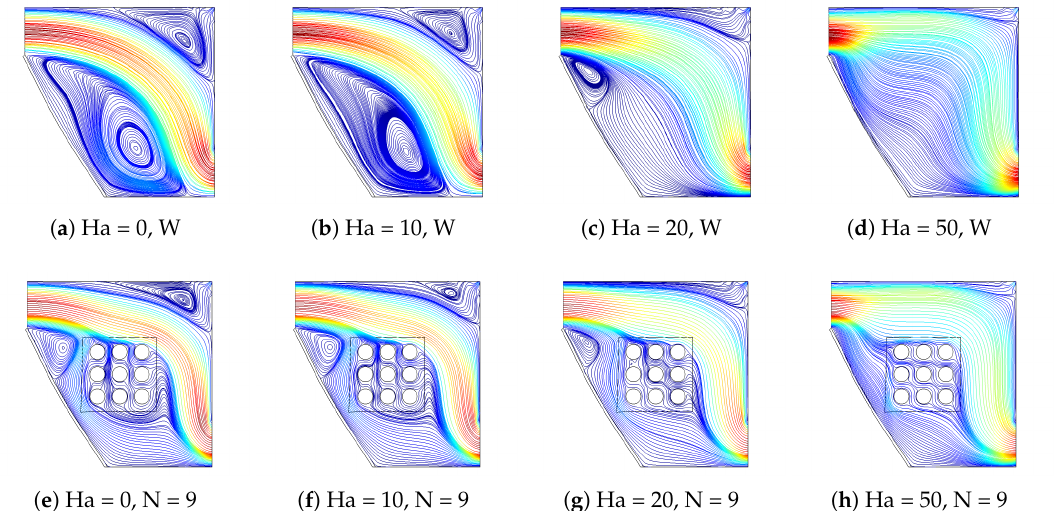
Figure 8. Streamline variations with different MGF strength for VC system without plate ( a – d ) and